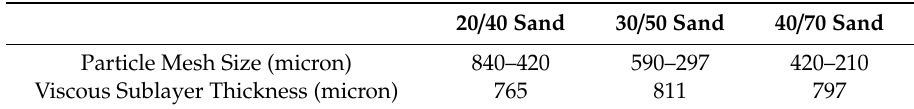
Table 6. Viscous sublayer thickness for the polymer fluid flow over the sand bed at their corresponding critical flow